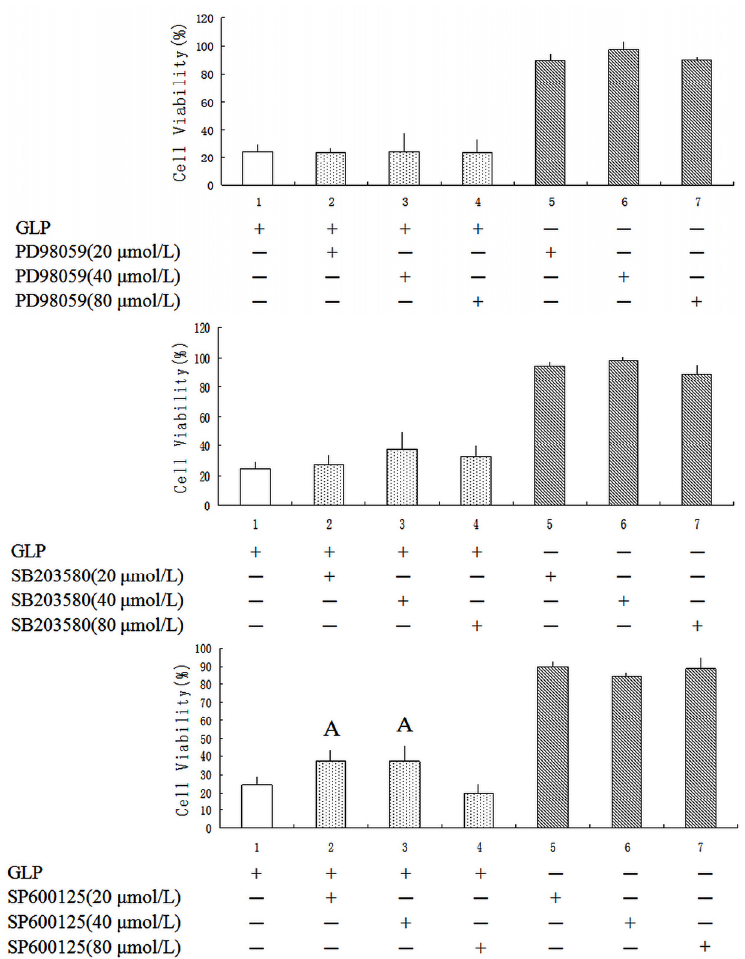
Figure 6. Effects of mitogen-activated protein kinase (MAPK) inhibitors on GLP-induced HCT-116 cell death. Cells were treated in the absence or presence of different MAPK-specific inhibitors, 1 h prior to the addition of GLP, and then incubated in 5 mg/mL GLP for 12 h. Cells were harvested to determine the percentage of viable cells as described Data expressed as mean ±